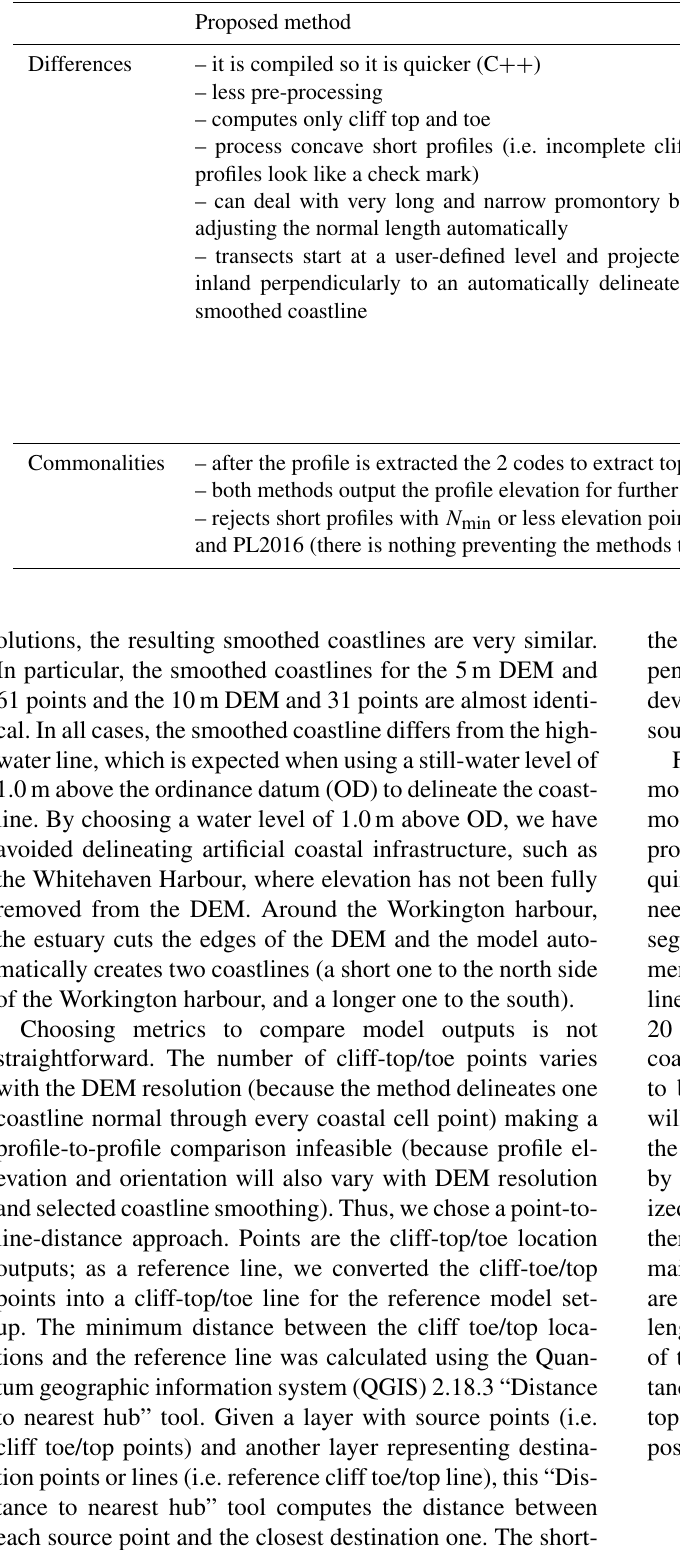
Table 3. Differences and commonalities of proposed method versus PL2016